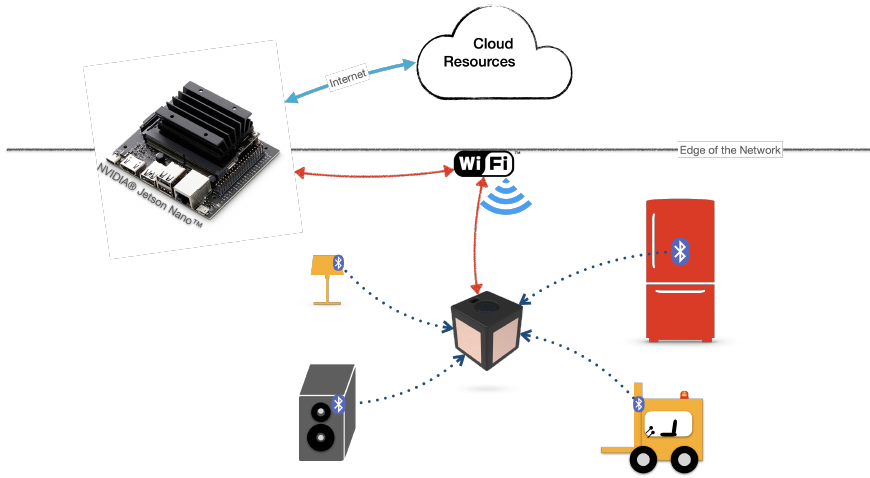
Figure 8. Schema of the proposed